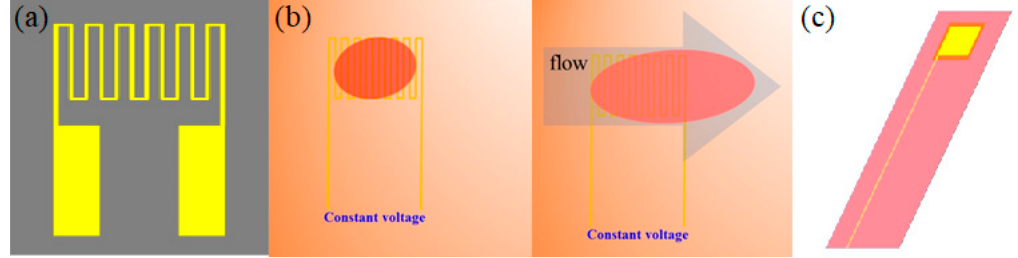
Figure 2. Schematic diagram of micro sensor: ( a ) Micro temperature sensor; ( b ) micro flow sensor; ( c ) micro voltage sensor.